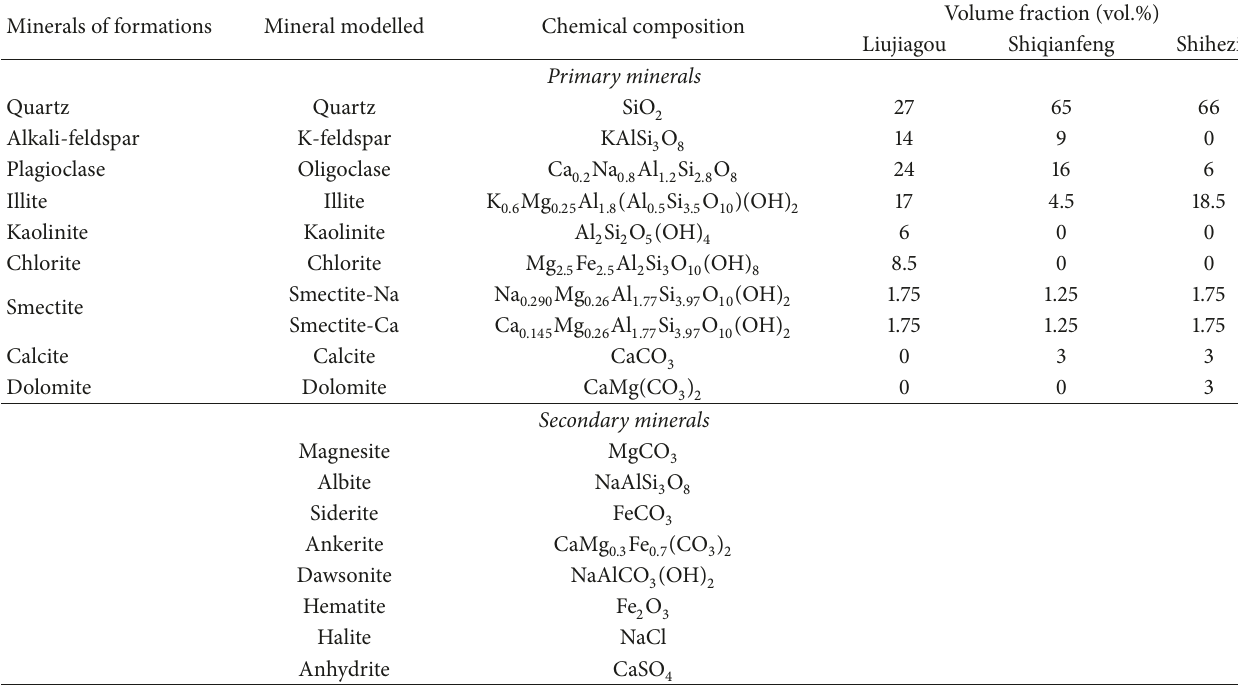
Table 1: Mineral composition of formations [25–27] and possible secondary minerals used in the simulations. Minerals of formations